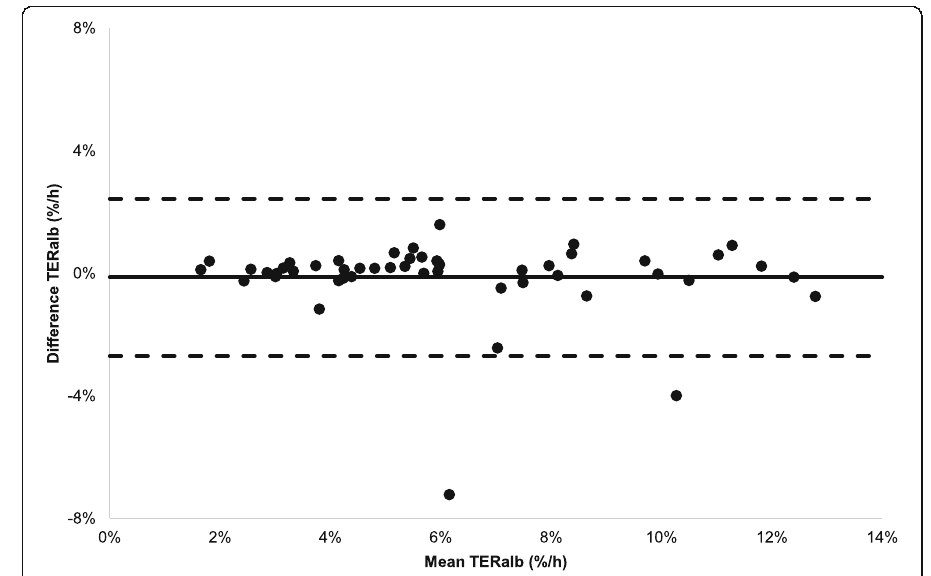
Fig. 5 Bland-Altman plot with differences between TER alb values calculated according T 20 – 60 min, bi-exp. scheme and the T 20 – 60 min reference scheme. Solid line: bias ( − 0.1%/h) between the two sampling schemes, dotted lines: 95% limits of agreement ( − 2.7 –